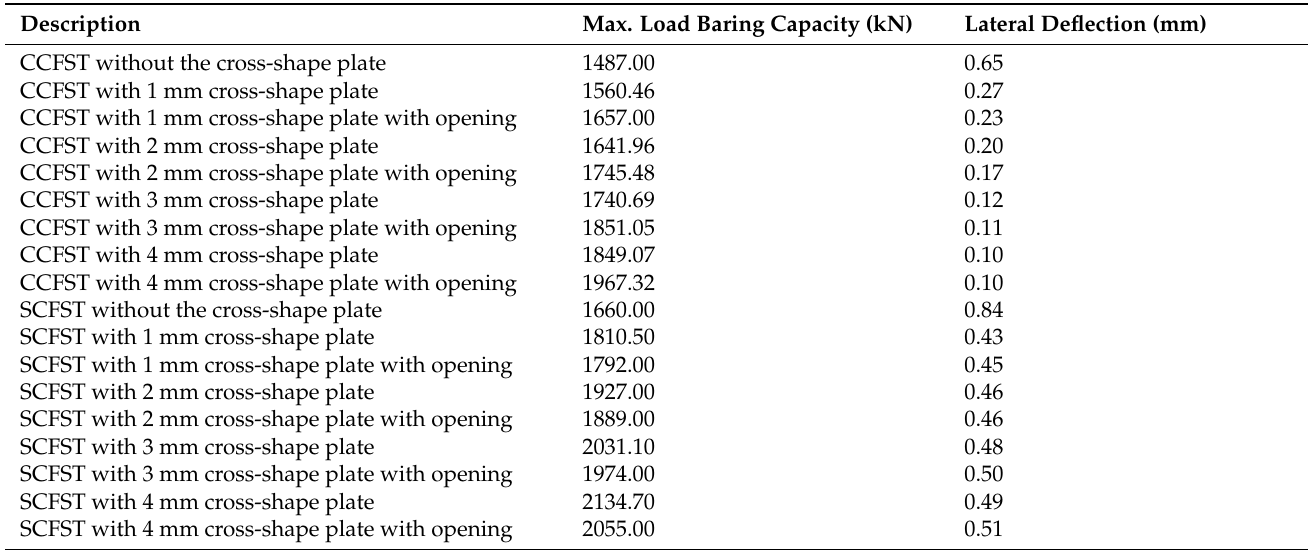
Table 7. Summary and comparison of the FEA results.